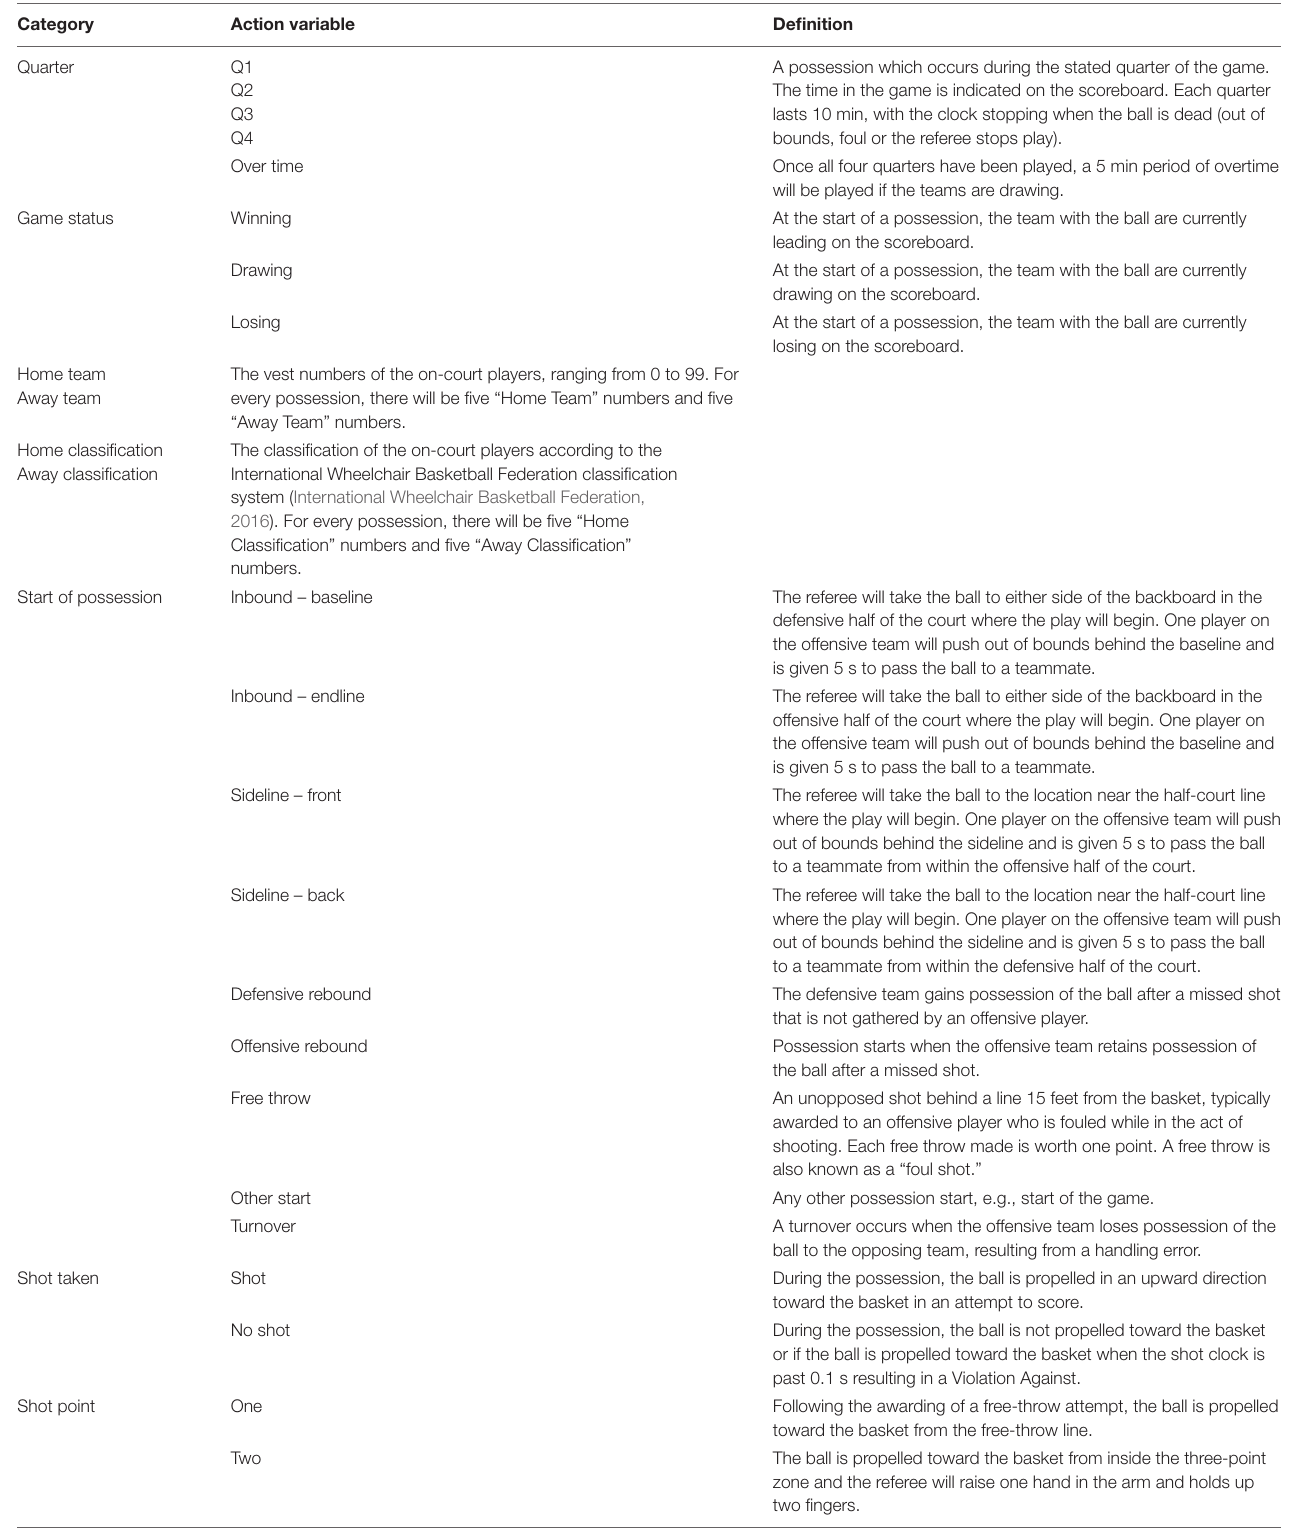
TABLE 1 | Operational definitions for the action variables in each